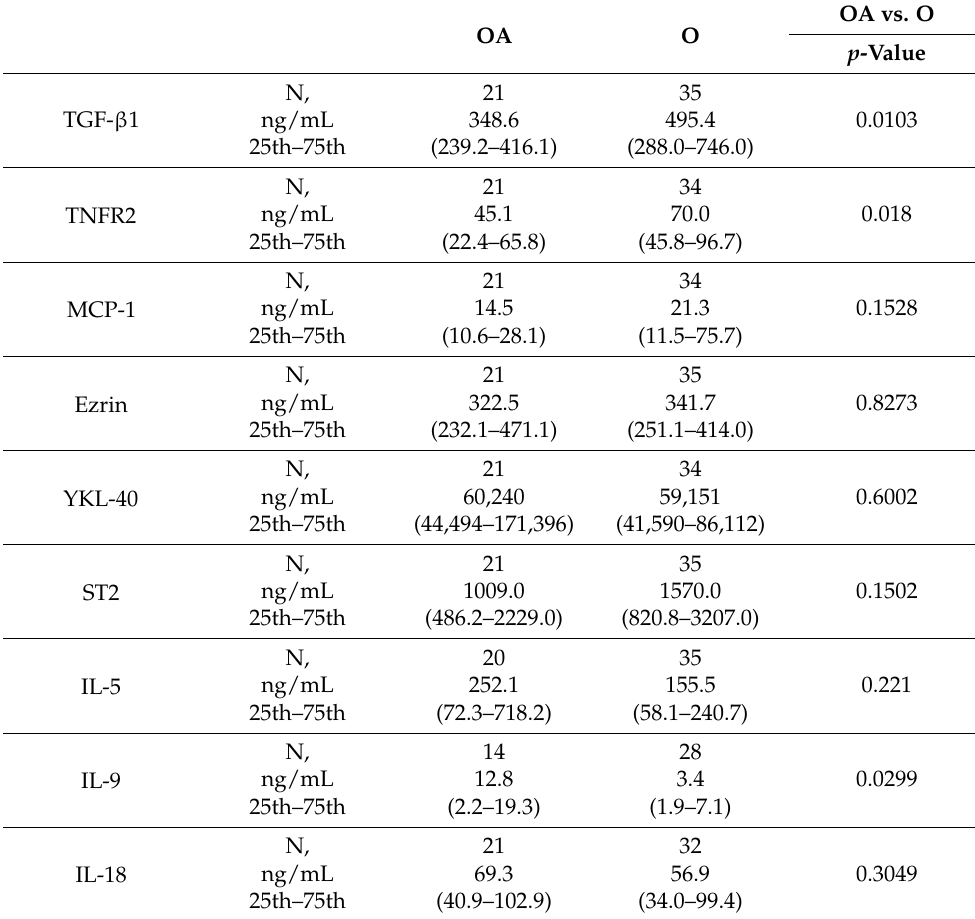
Table 4. Serum cytokine level comparison between obese groups with and without asthma.